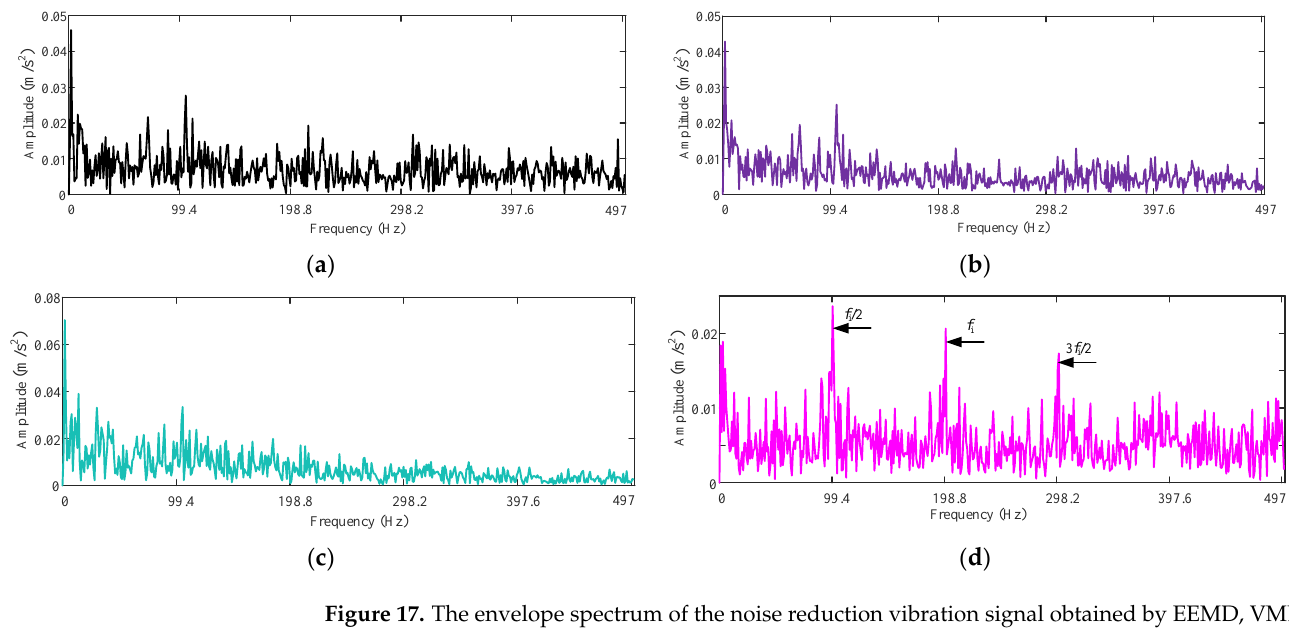
Figure 17. The envelope spectrum of the noise reduction vibration signal obtained by EEMD, VMD, WPD, and the proposed method in Case 2. ( a ) EEMD; ( b ) VMD; ( c ) WPD; ( d ) The proposed method.